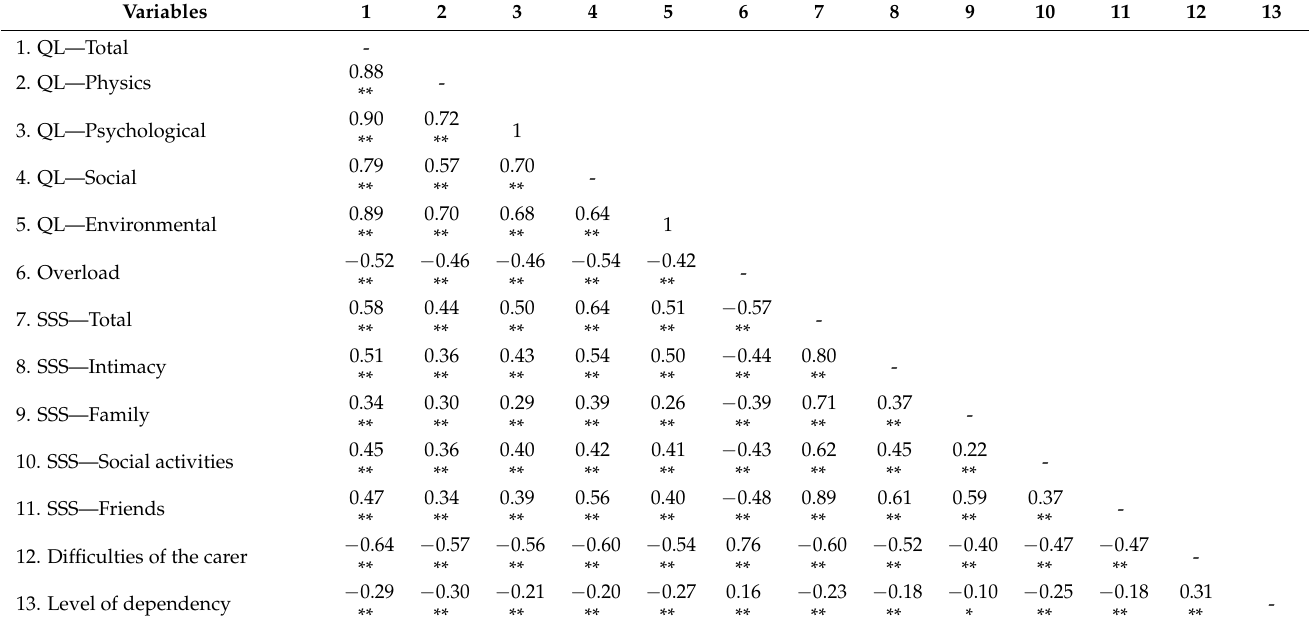
Table 4. Results of the study of the association between the dimensions of quality of life, satisfaction with social support, difficulties of the caregiver, and level of